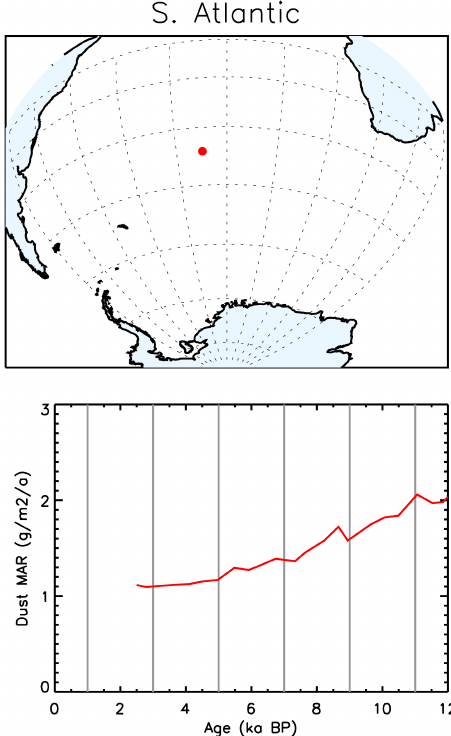
Figure 14. Same as Fig. 6 but for the South Atlantic Ocean.